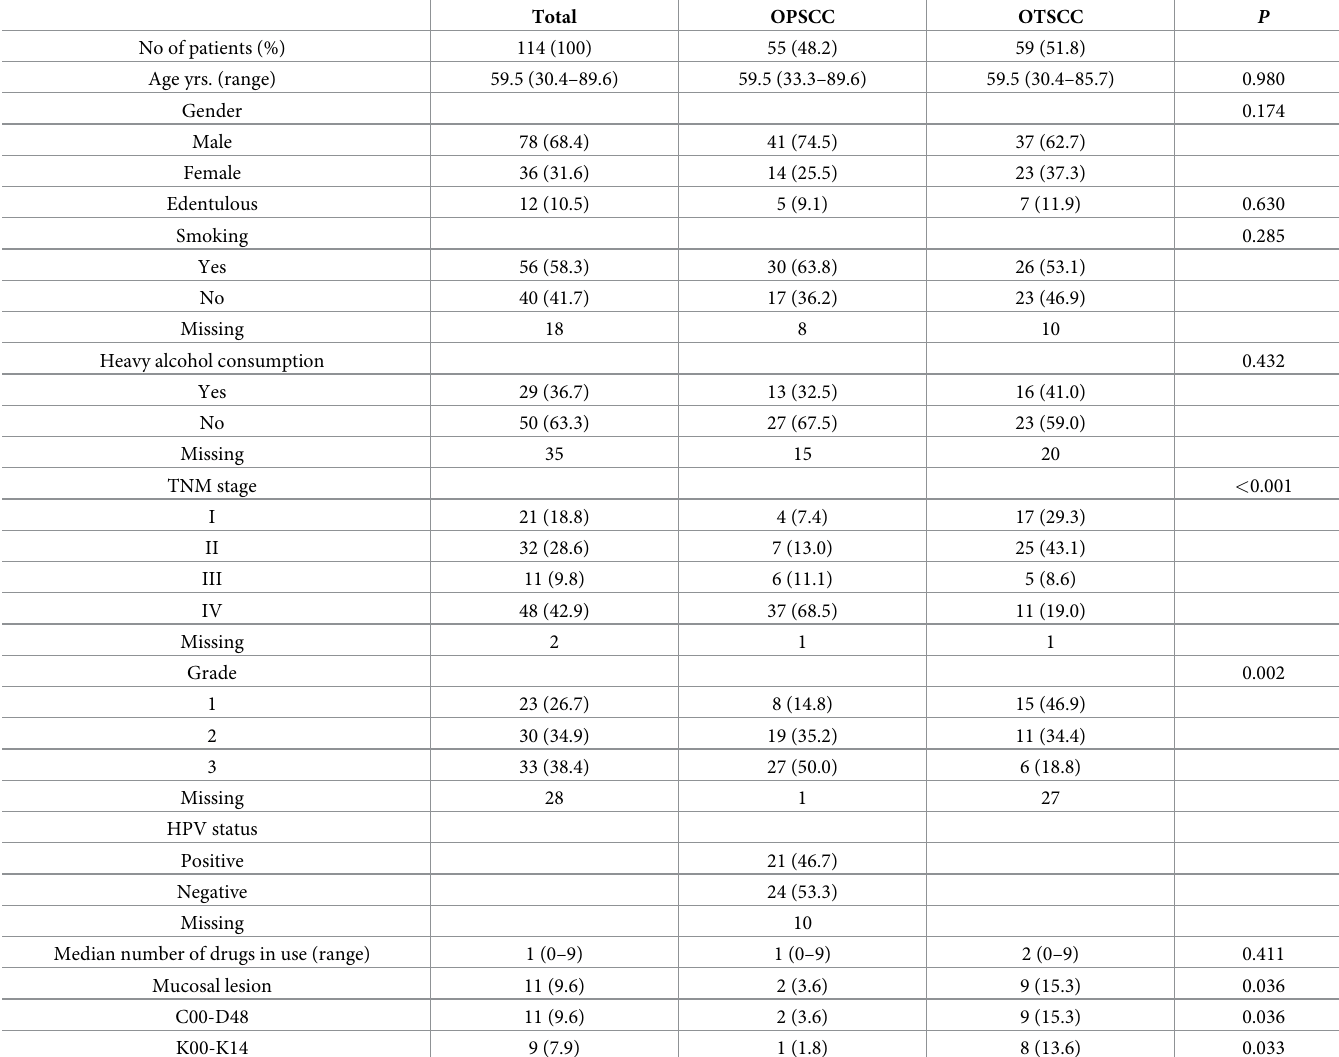
Table 1. Baseline clinic-pathological characteristics of the patients with oropharyngeal (OPSCC) or oral tongue (OTSCC) squamous cell